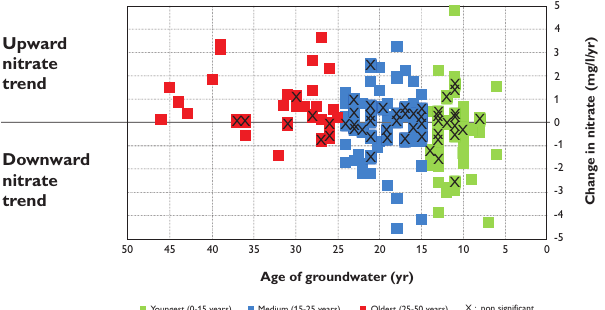
Fig. 4. Three age groups of upward and downward nitrate trends in oxic groundwater at a monitoring point level for 152 oxic CFC- dated groundwater measuring points sampled from 1988 to 2009. The change in nitrate (mgl − 1 yr − 1 ) is equivalent to the slope of the linear regression lines of nitrate versus sampling year for each groundwater monitoring point. The age of the groundwater is deter- mined with the CFC